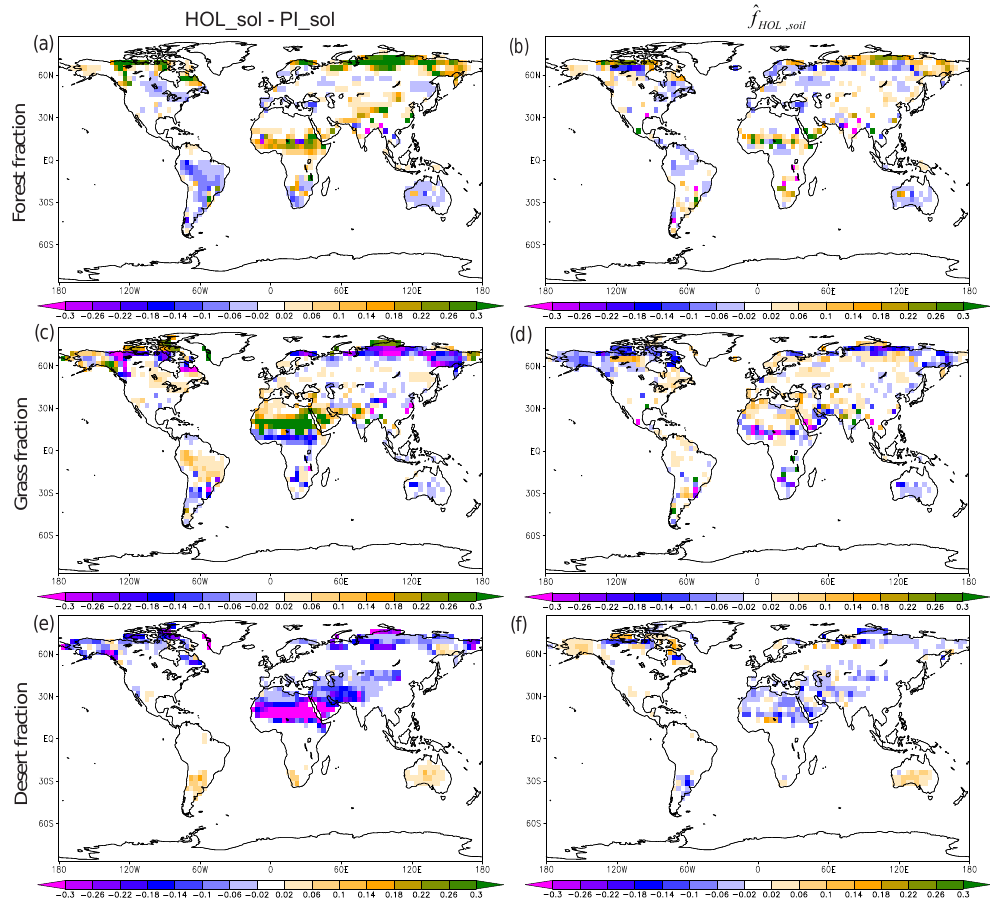
Figure 7. Vegetation differences in 100-year mean of the mid-Holocene and preindustrial climate state with dynamic soils (HOL_sol – PI_sol) and enclosed soil feedback ( ˆ f HOL,soil ) included for (a) forest fraction and (b) soil impact on forest fraction, (c) grass fraction and (d) soil impact on grass fraction, (e) desert fraction and (f) soil impact on desert